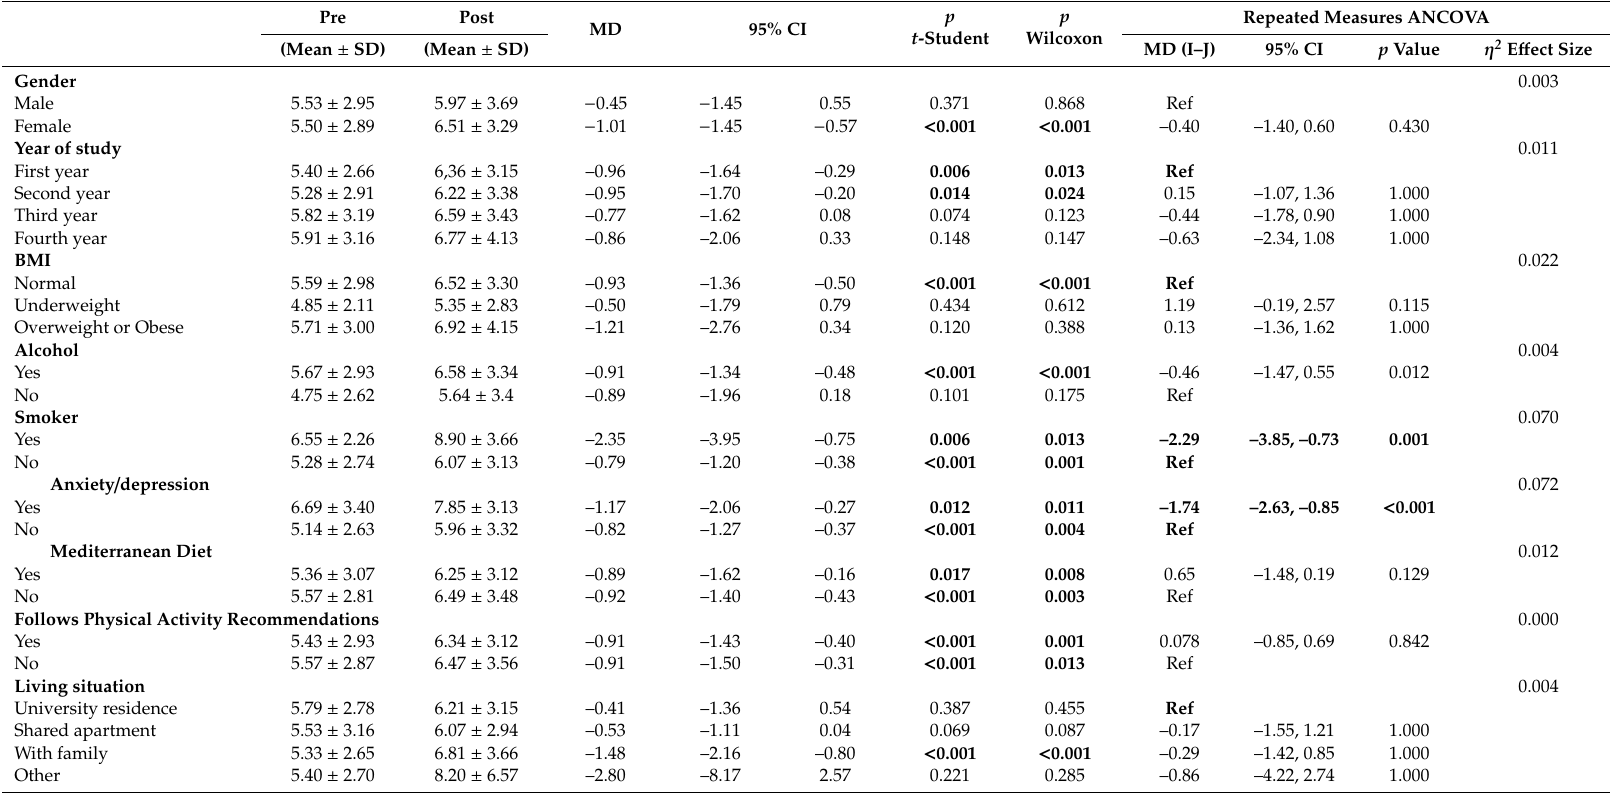
Table 3. PSQI score pre- and post-stratification by group. Parametric and nonparametric bivariate